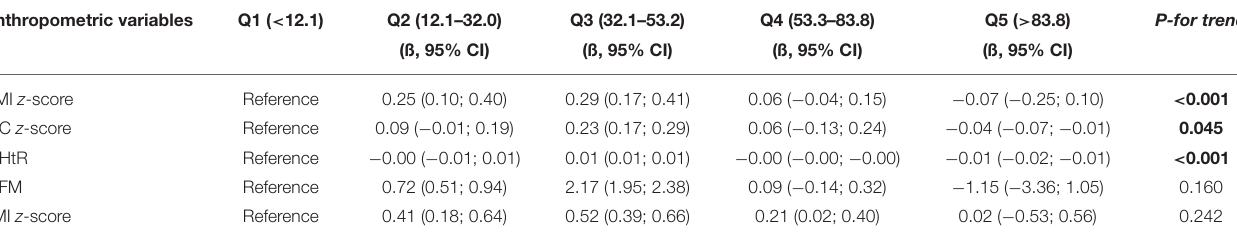
TABLE 4 | Association between flavonoid intake from cocoa-based products (mg/day) and anthropometric measurements. Anthropometric